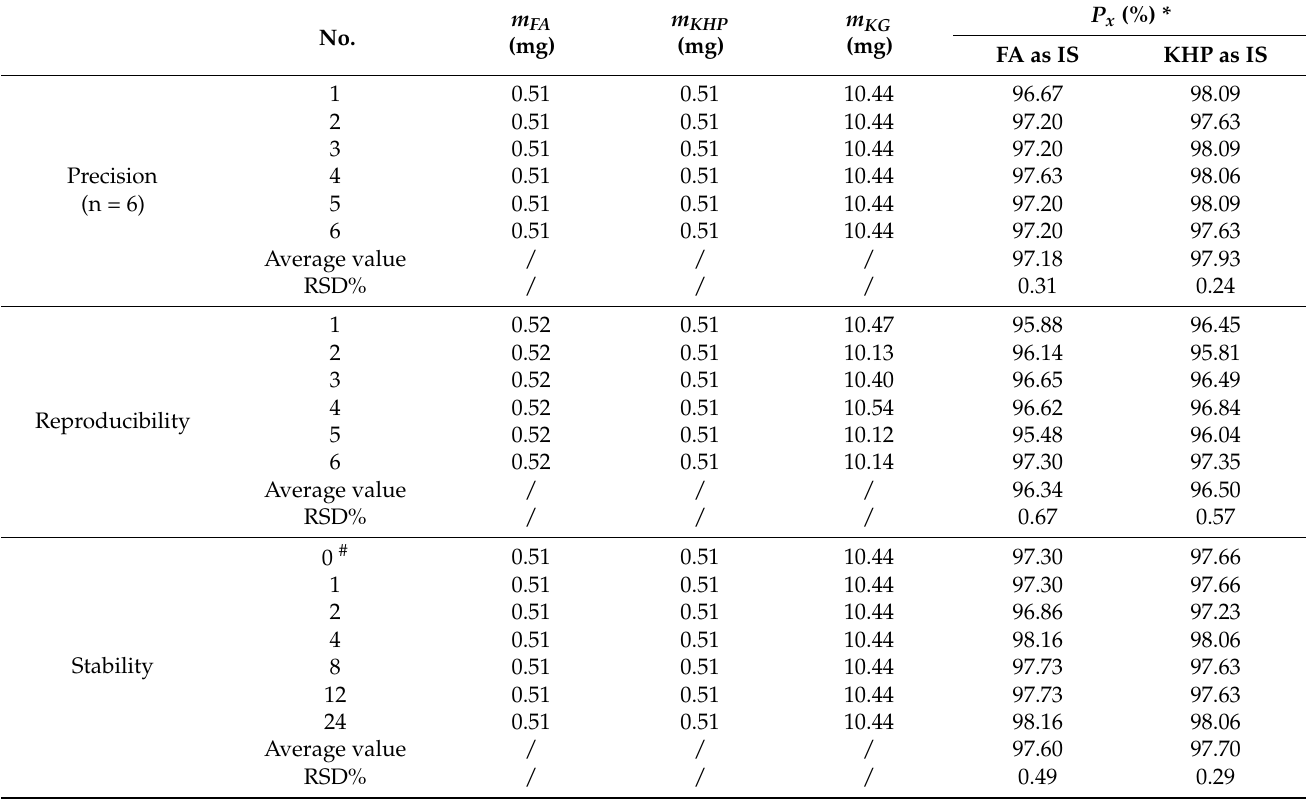
Table 2. Precision, reproducibility, and stability of dipotassium glycyrrhizinate by